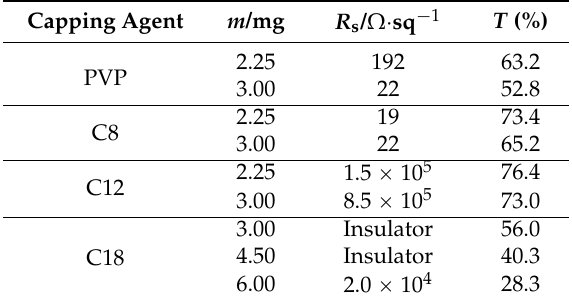
Table 2. Resistance and Transmittance values of AgNW films built by spray coating. Sheet resistance ( R s ); Transmittance ( T ).